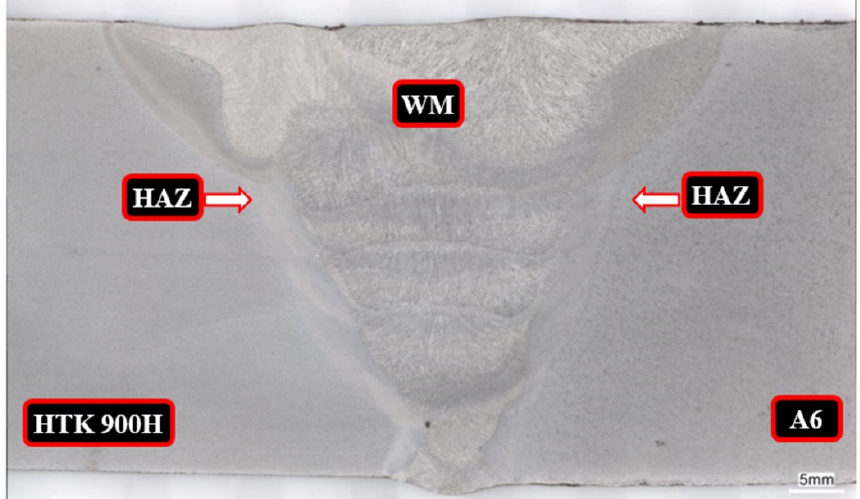
Figure 2. Macroscopic cross-section of HTK 900H/A6 casting welded joint, where: WM—weld metal; HAZ—heat affected zone; HTK 900H—HTK 900 steel; A6—A6 cast steel.